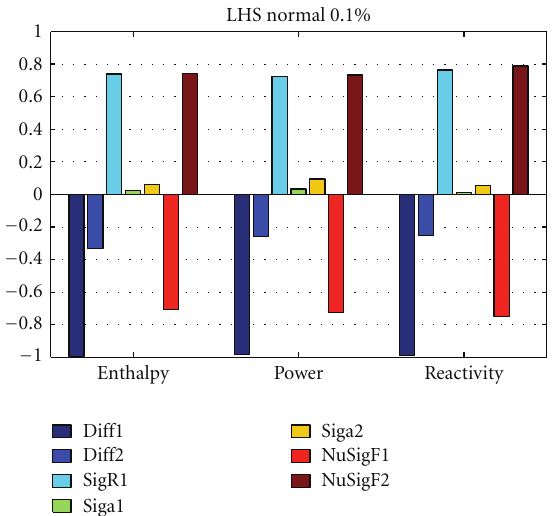
Figure 5: Partial rank correlation coe ffi cient for maximum power, maximum enthalpy, and maximum reactivity for LHS normal 0.1% case (1: Di ff 1 , 2: Di ff 2 , 3: SigR1 , 4: Siga1 , 5: Siga2 , 6: NuSigF1 , 7: NuSigF2